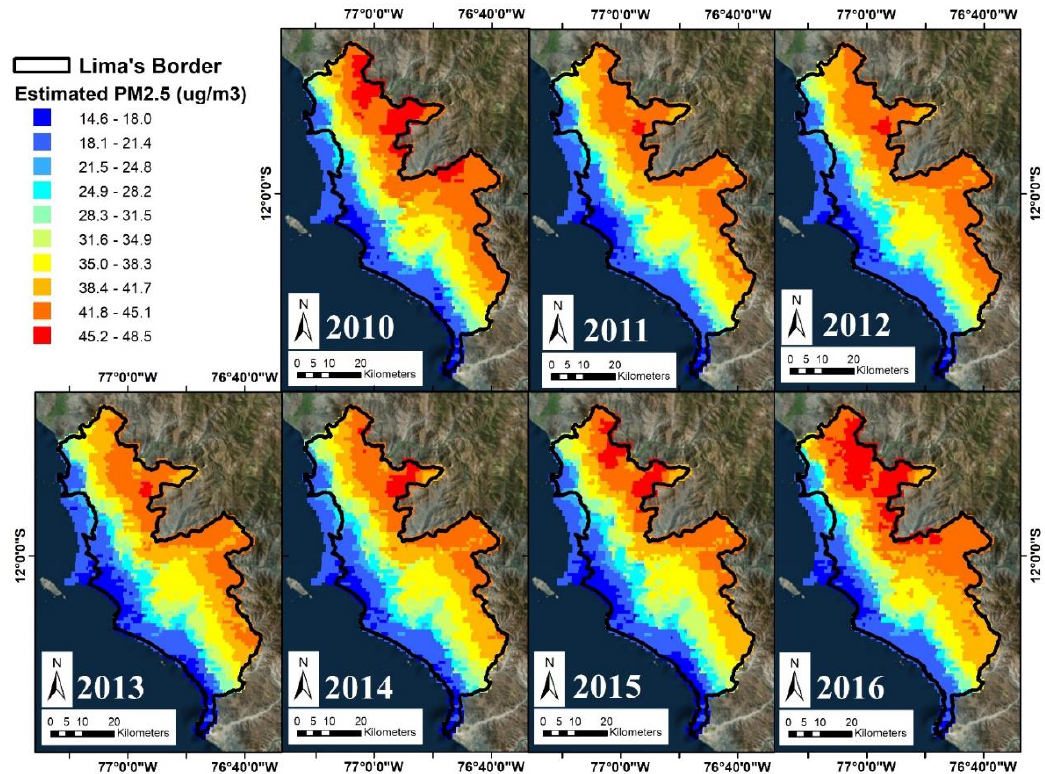
Figure 6. Annual mean prediction maps of PM 2.5 in µg/m 3 from the random forest model in Lima, Peru from 2010 to 2016.